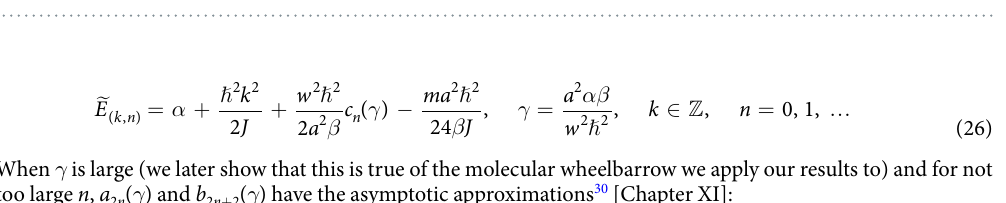
Table 2. Lagrangians, constraints, and configuration spaces Q for five models of the molecular